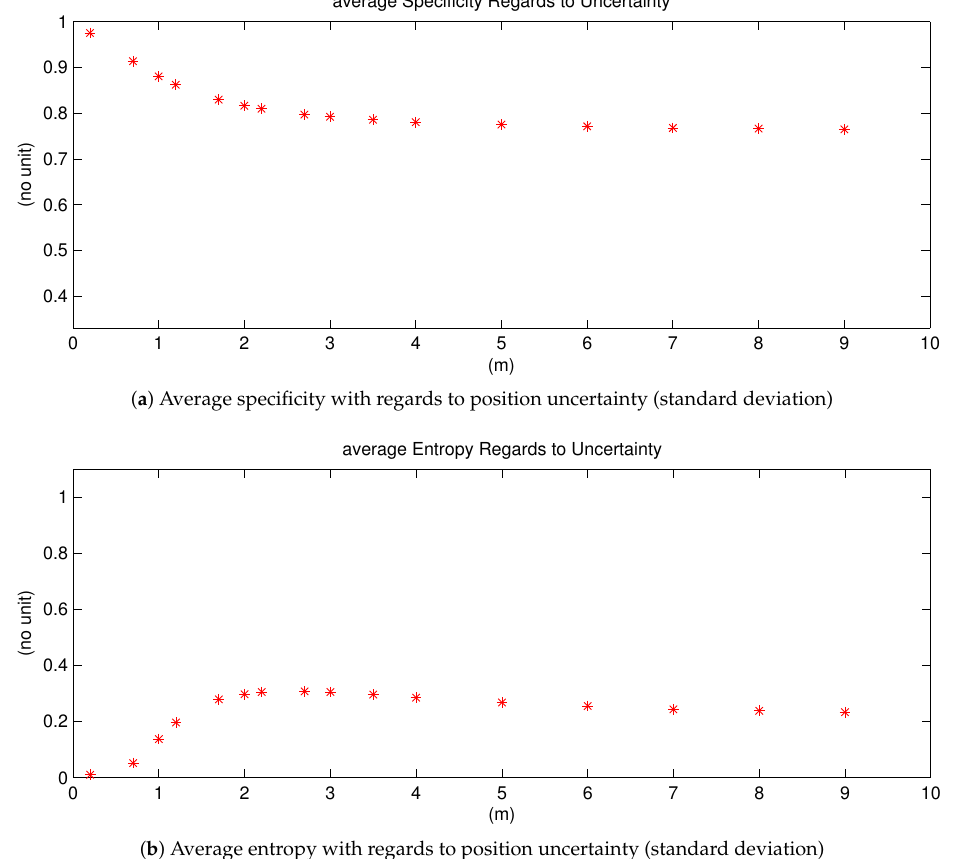
Figure 17. Average specificity and average entropy with regards to position uncertainty